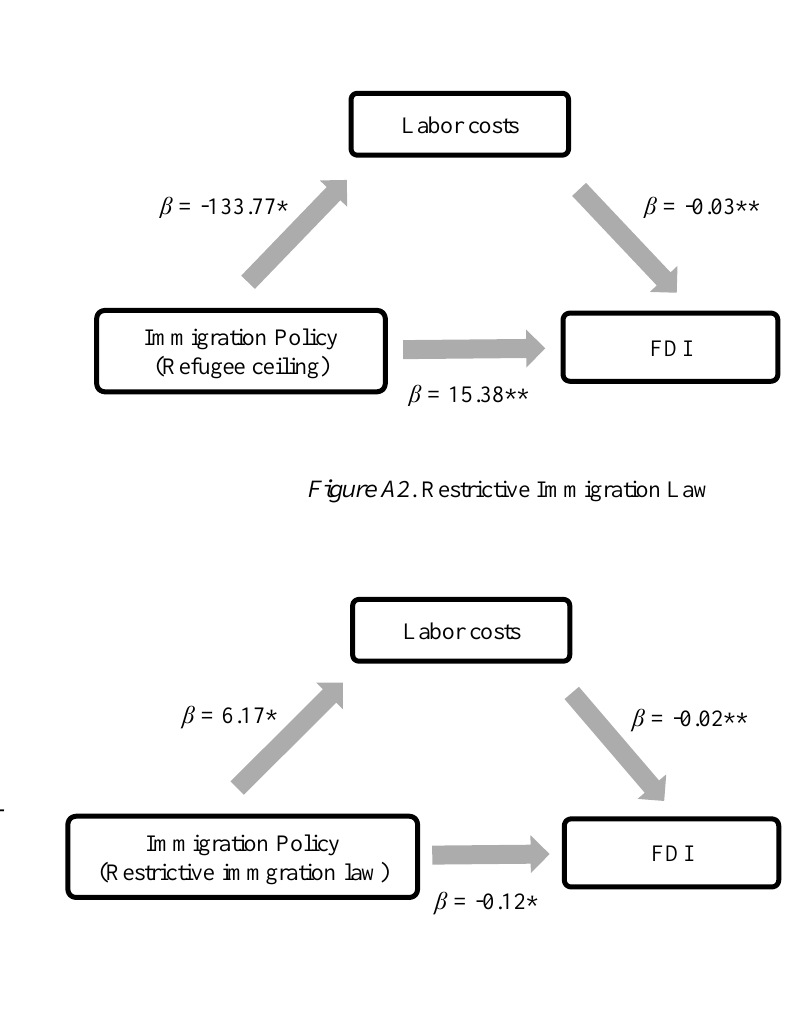
Figure A1. Refugee Ceiling per Capita